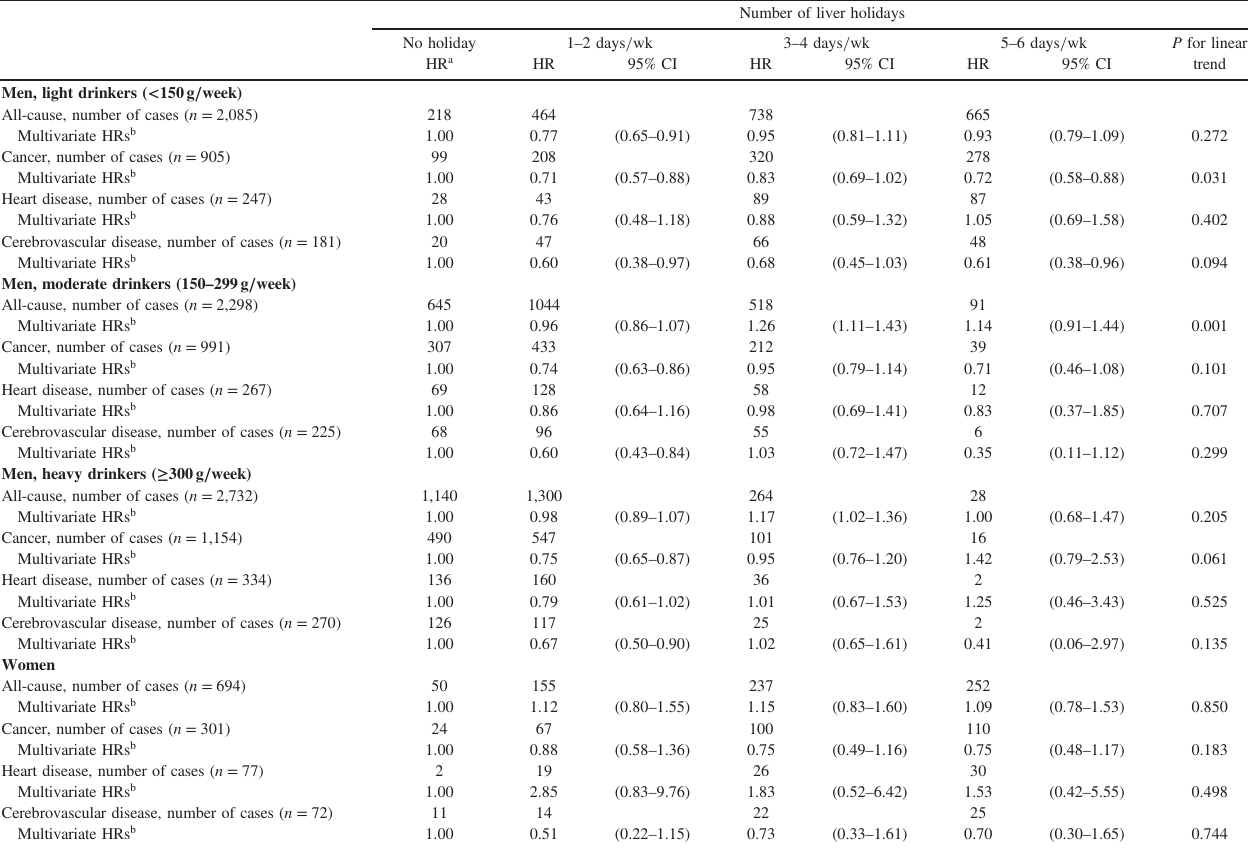
Table 4. Adjusted hazard ratios by the number of liver holidays per week in regular drinkers